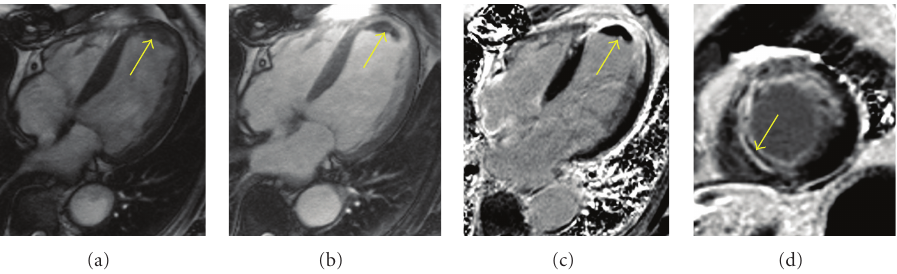
Figure 3: CMR imaging after acute MI. The tissue characterization abilities of CMR are demonstrated in these frames, all of which were taken from a patient who presented late after an ST elevation MI. A 4-chamber cine steady-state free precession (SSFP) image is shown in (a). Prior to contrast, it is di ffi cult to discern whether there is thrombus in the apex. A postcontrast 4-chamber SSFP image (b) provides greater contrast between the slightly enhancing myocardium and nonenhancing thrombus at the apex. This di ff erence is even more clear with late gadolinium-enhanced (LGE) imaging (c)-(d), which clearly demonstrates the black thrombus at the apex adjacent to the transmural apical infarct seen in white. An apical short axis view (d) reveals an extensive infarct with an area of microvascular obstruction visualized in the septum (arrow).